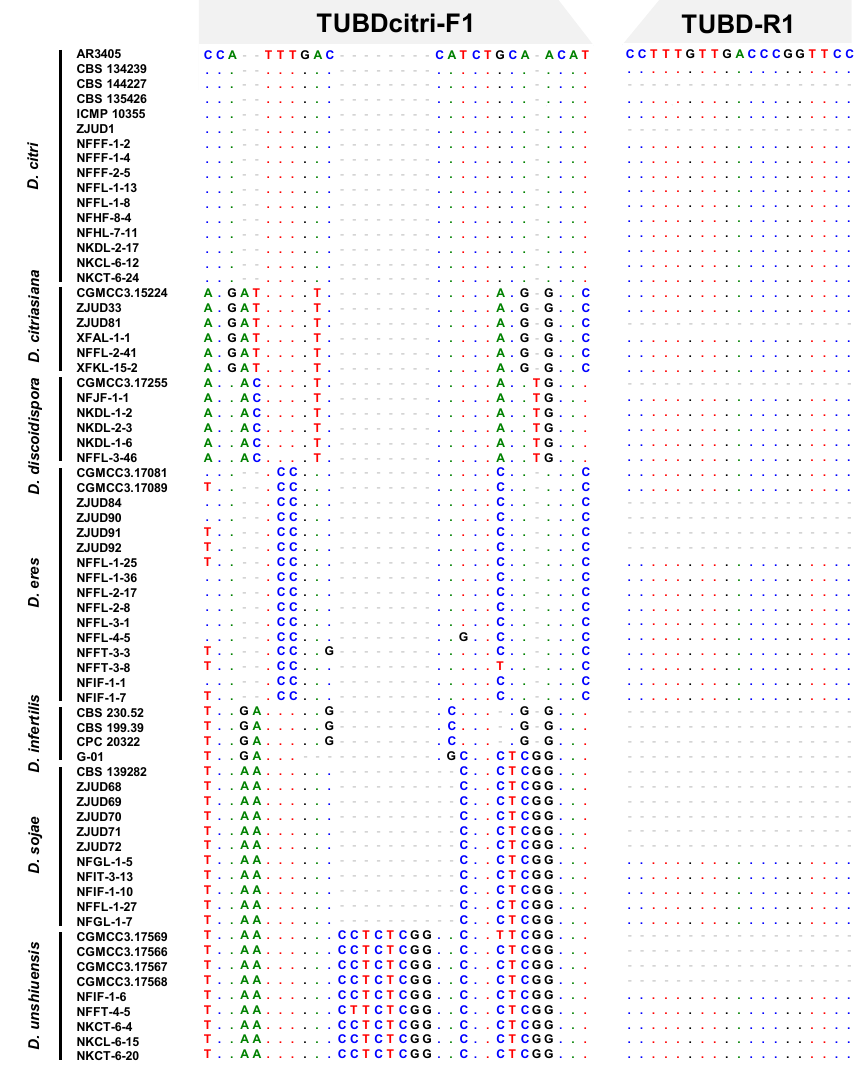
Figure 5. A novel primer pair TUBDcitri-F1 and TUBD-R1 was designed based on the alignment of the partial TUB gene (from 5´ to 3´) of Diaporthe species including D. citri , D. citriasiana , D. discoidispora , D. eres , D. infertilis , D. sojae , and D. unshiuensis . Dashes ( − ) and dots (.) indicate the gaps and identical nucleotides in the sequences, respectively.